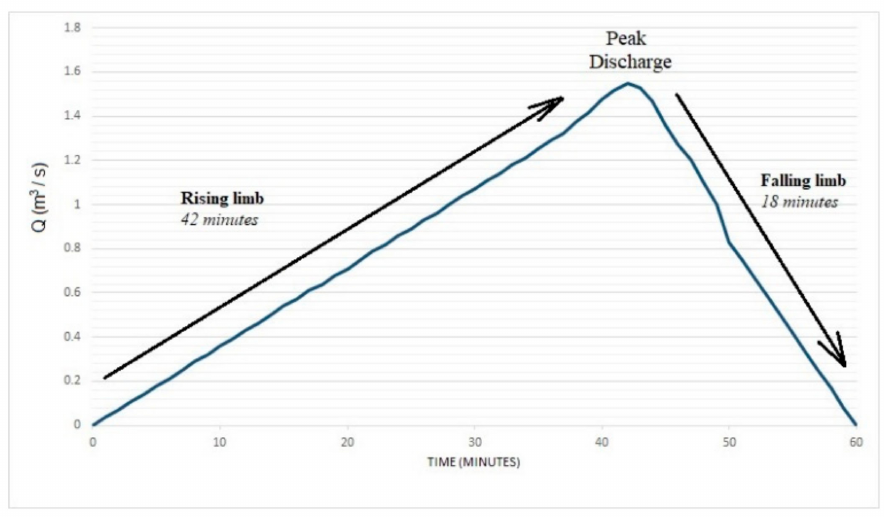
Figure 7. Simulated flow